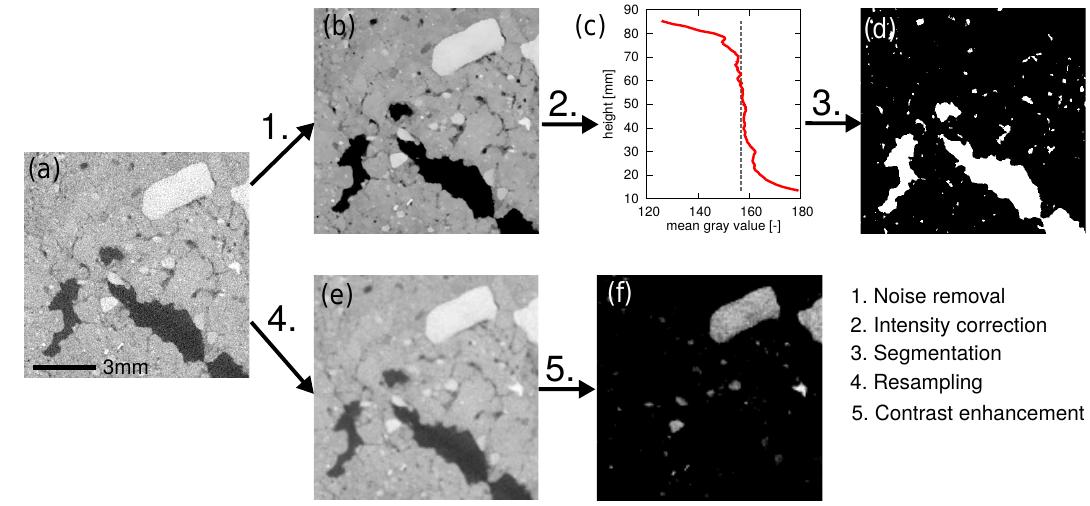
Figure 1. Image processing workflow for this study depicted for a small two-dimensional subset (a) . Noise is removed with a non-local means filter (b) . Shading and cone beam artifacts evoke differences in image intensity which are corrected by subtracting the difference between the depth-dependent gray value average of the soil matrix from the mean gray value of the entire soil matrix (c) . Subsequently, image segmentation is performed with multi-level Otsu thresholding (d) . For digital image correlation all images are resampled from a voxel size of 61 to 183µm to reduce memory consumption (e) . Optionally, the grayscale range is adapted such that rocks are depicted with optimal contrast and macropores vanish (f)